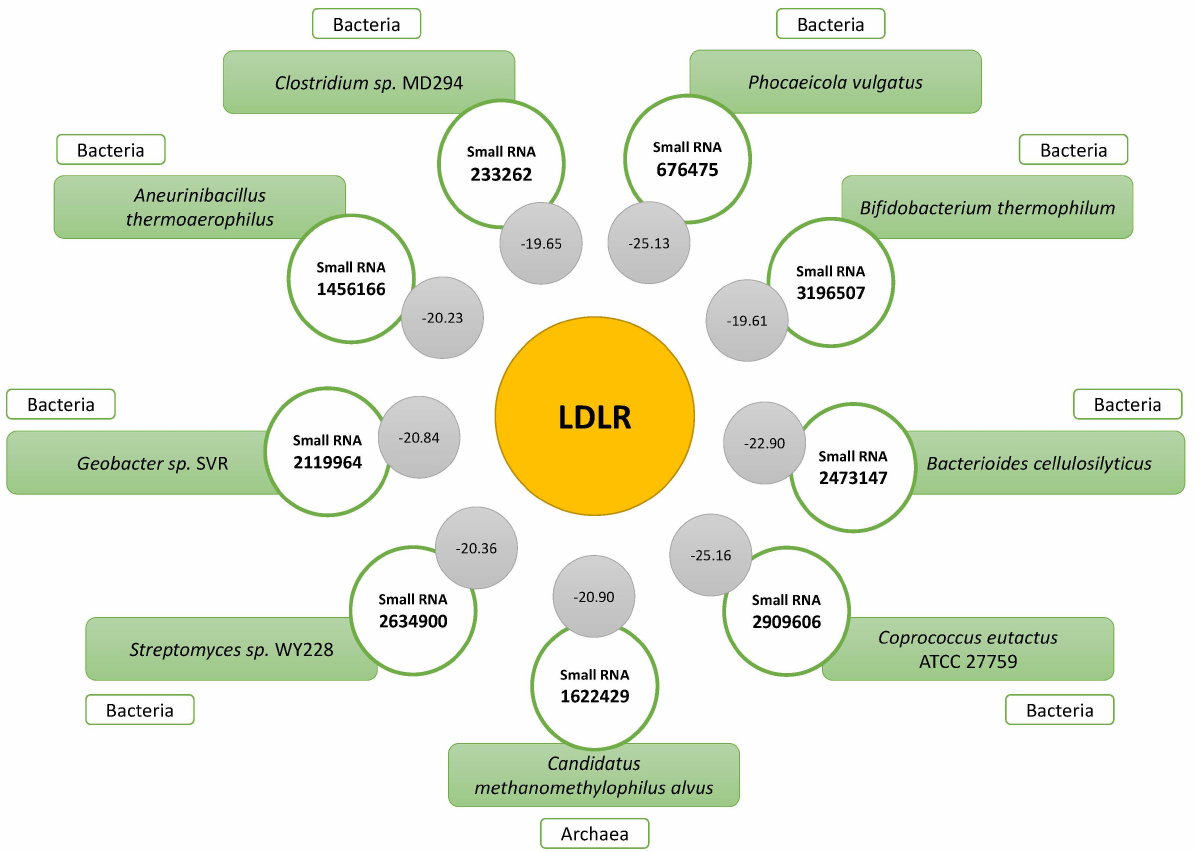
Figure 7. Small RNAs showing significant complementarity with mRNA LDLR. The binding energy levels associated with each interaction are indicated in the gray